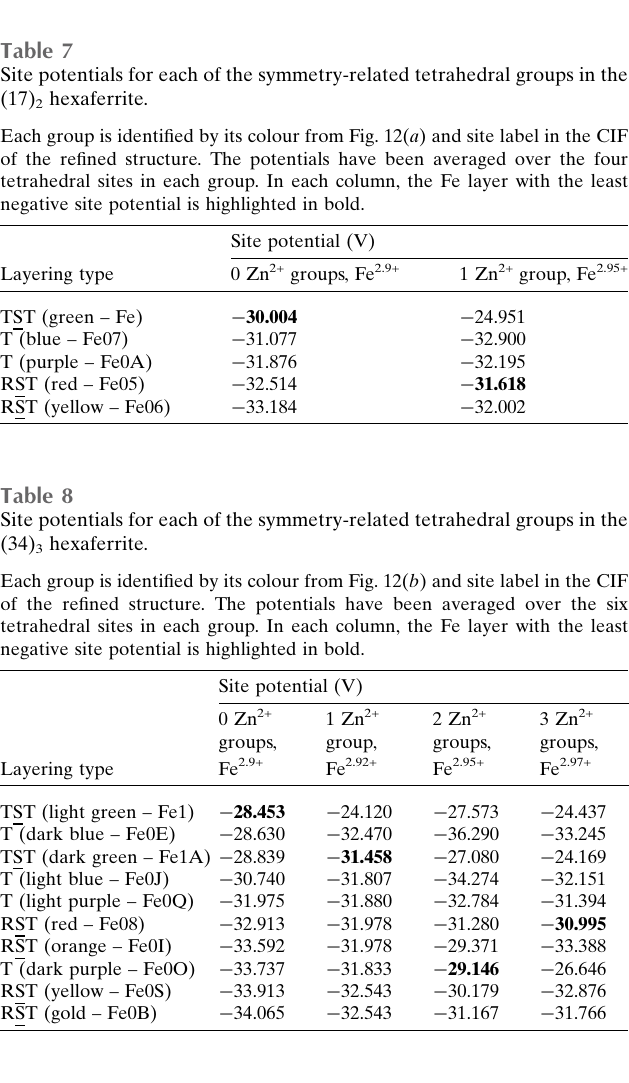
Table 7 Site potentials for each of the symmetry-related tetrahedral groups in the (17) 2 hexaferrite. Each group is identified by its colour from Fig. 12( a ) and site label in the CIF of the refined structure. The potentials have been averaged over the four tetrahedral sites in each group. In each column, the Fe layer with the least negative site potential is highlighted in bold.